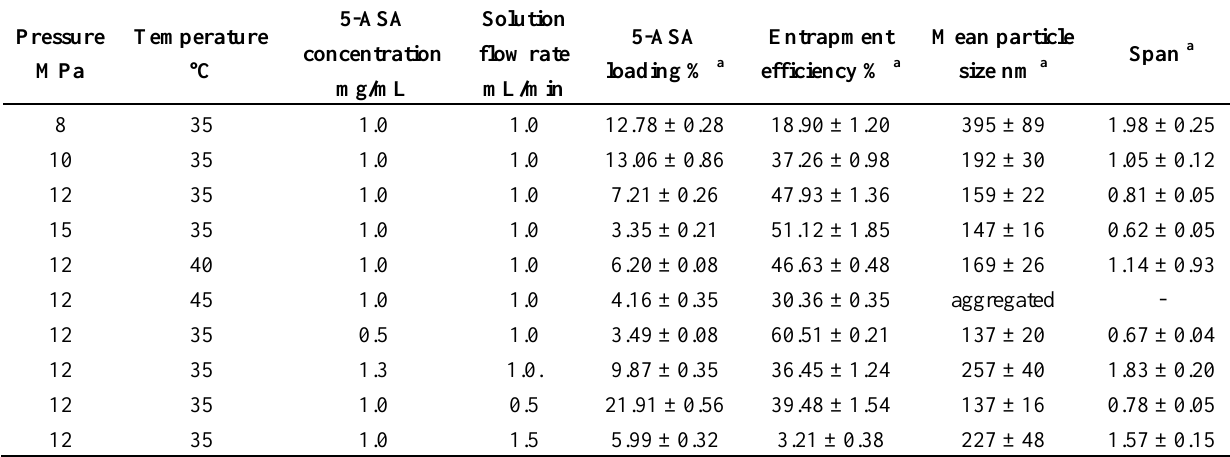
Table 1. Experiment conditions and partial results of solution enhanced dispersion by supercritical fluids (SEDS)